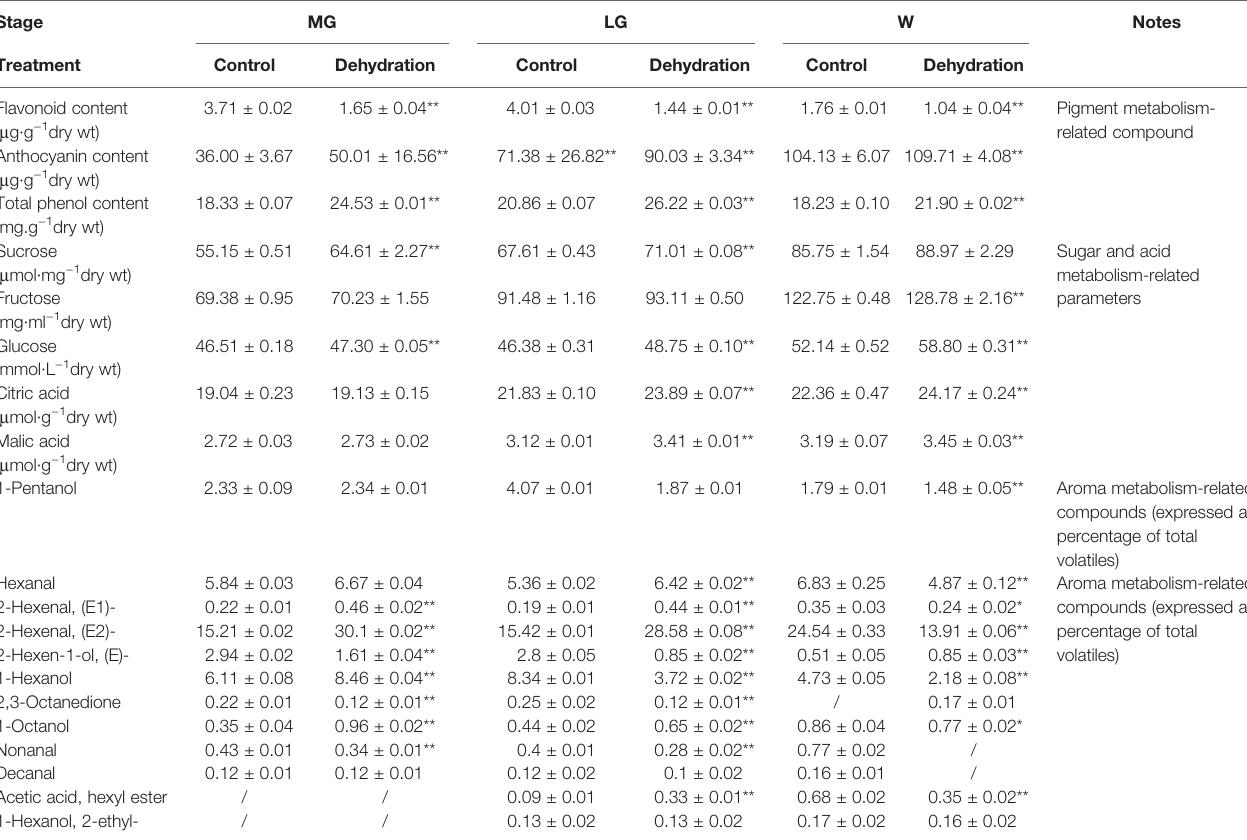
TABLE 1 | Effects of dehydration treatment on major fruit ripening-related parameters.